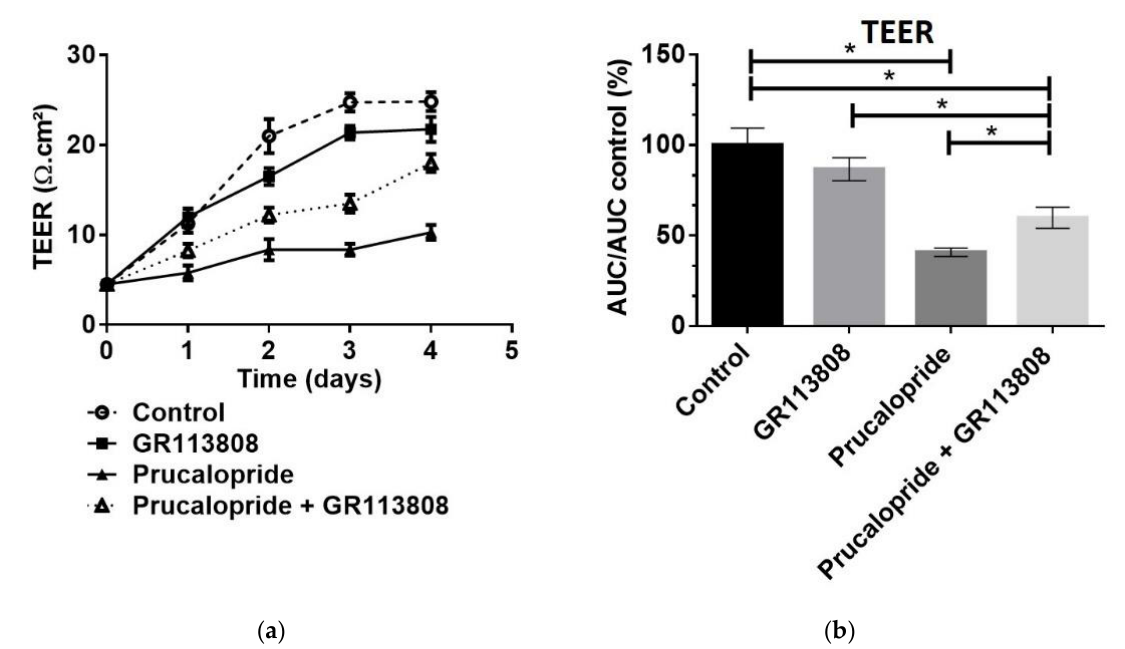
Figure 4. Prucalopride effect on blood–brain barrier TEER in hCMEC/D3 cells. All cells are depleted of fetal bovine serum at day 3 after the start of treatment. Cells are treated with prucalopride, GR113808 or GR113808 + prucalopride for 96 h. ( a ) Daily measured TEER shows a constant increase in TEER in control cells. Treatment with prucalopride for 96 h decrease the TEER attesting the blood–brain barrier opening when GR113808 alone does not change the TEER compared to control. ( b ) The AUC TEER calculated from 0 to 96 h of treatment indicate a significant decrease after prucalopride treatment. GR113808 prevents the effect of prucalopride. Histograms represent mean ± SEM from three independent experiments. * p < 0.05; TEER: trans-endothelial electric resistance; AUC: area under the curve.